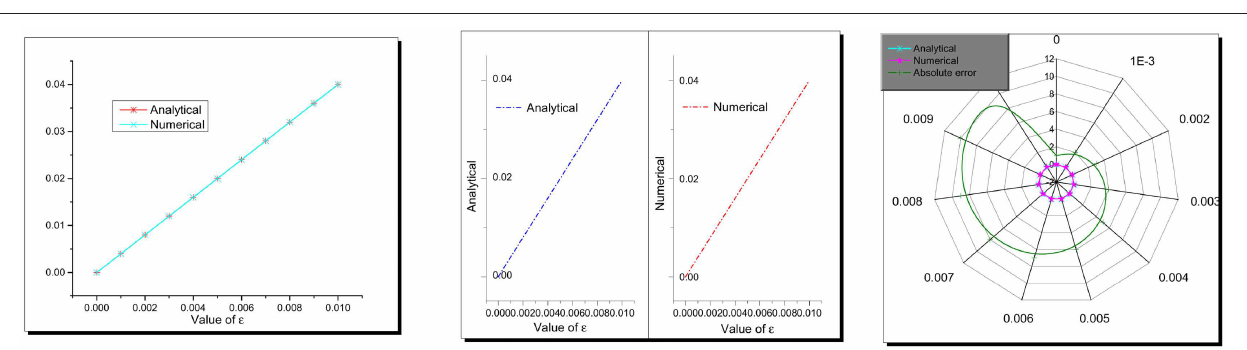
FIGURE 2 | Combined, separated, and radar plots of analytical (7) and semi-analytical solutions (12) of Equation (6), respectively.